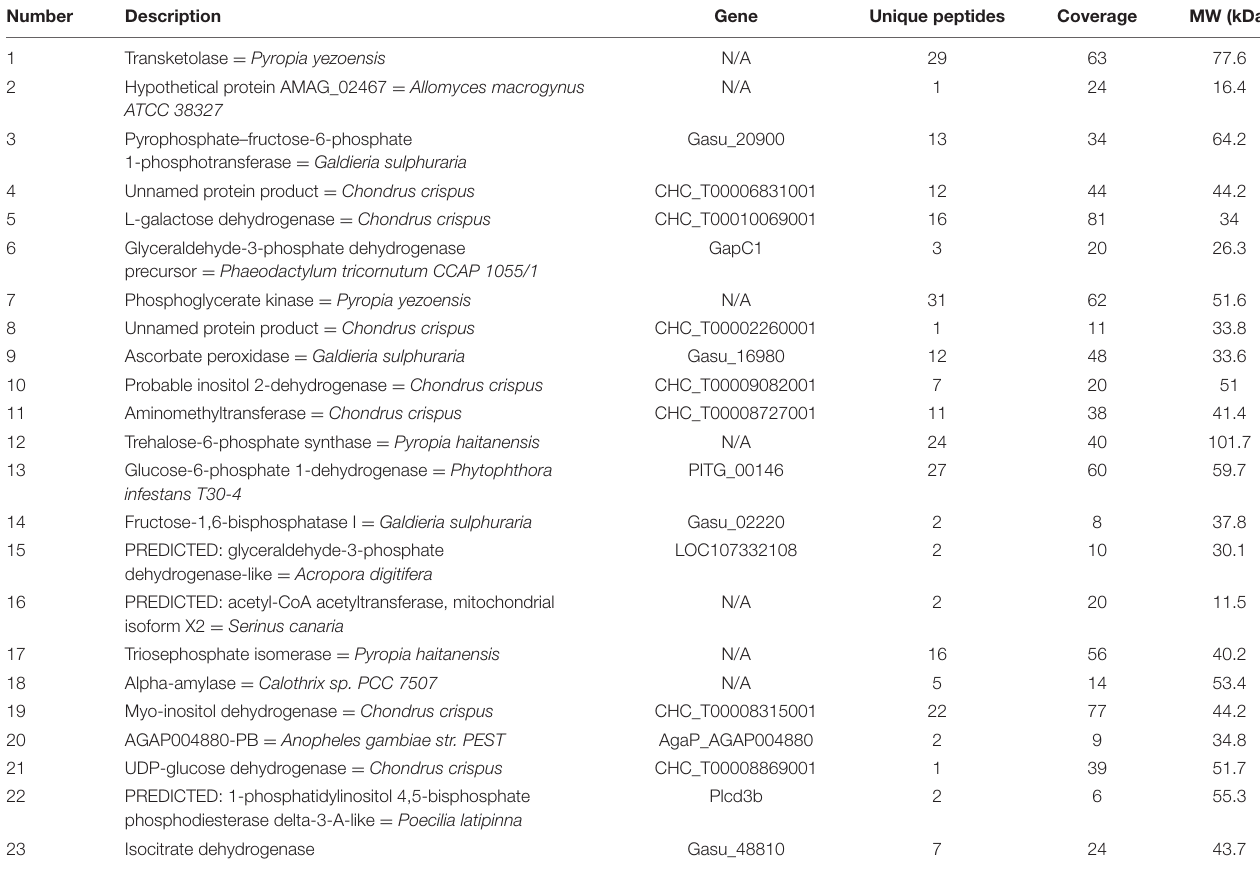
TABLE 2 | Carbohydrate metabolism